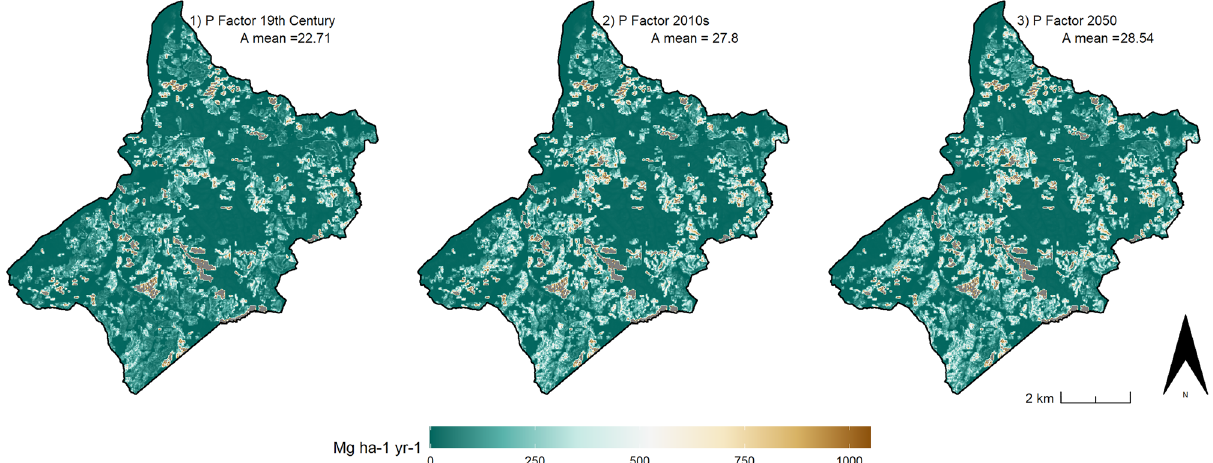
Figure 15. The impact that different degrees of conservation of historic landscape features would have on soil erosion based on latest projections on global rainfall in 2050). Image generated with software RStudio Desktop 2022.07.2 + 576 (https:// www. rstud io.